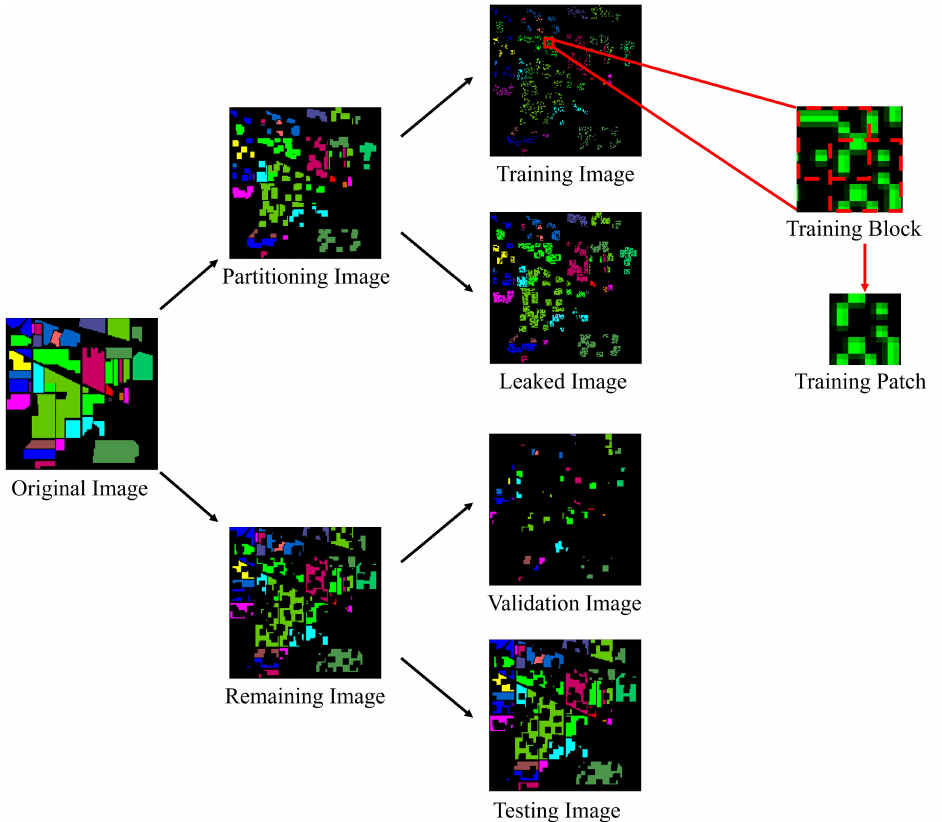
Figure 5. The partition process of the training/validation/testing datasets. The sliding window strategy is adopted from Training Block to Training Patch, and the methods for obtaining Validation Patch and Testing Patch are